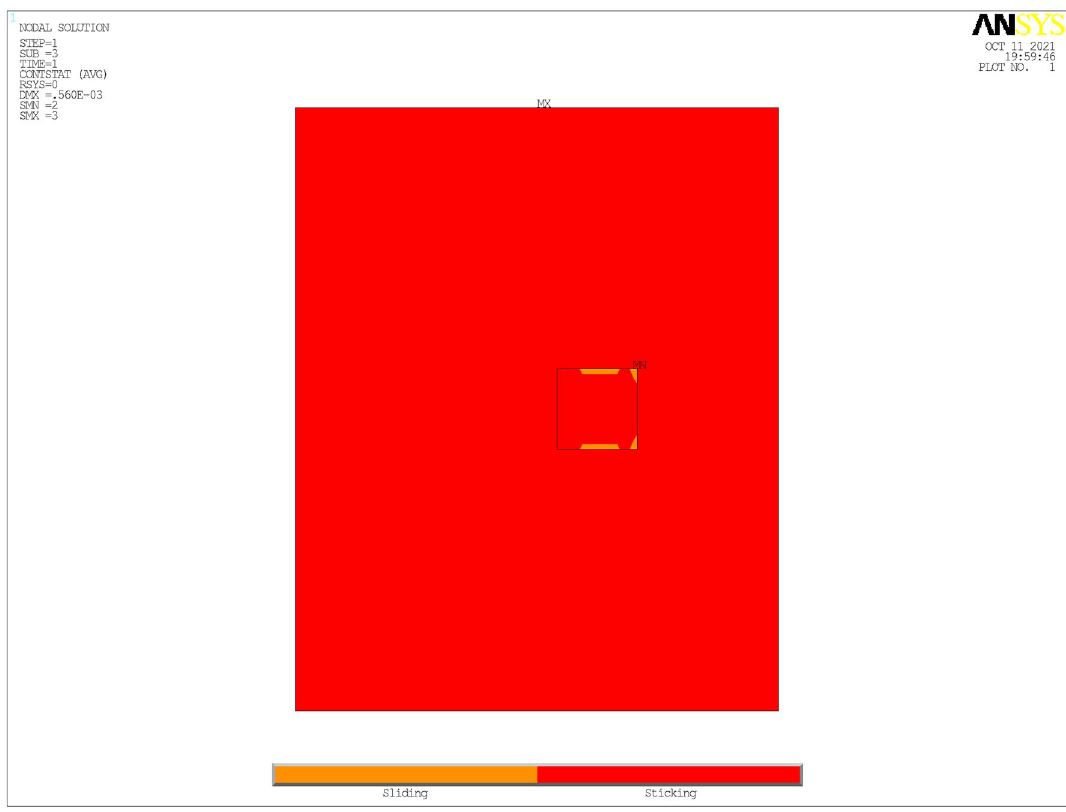
Figure 11. Contact bonding state between the GA layer and the steel